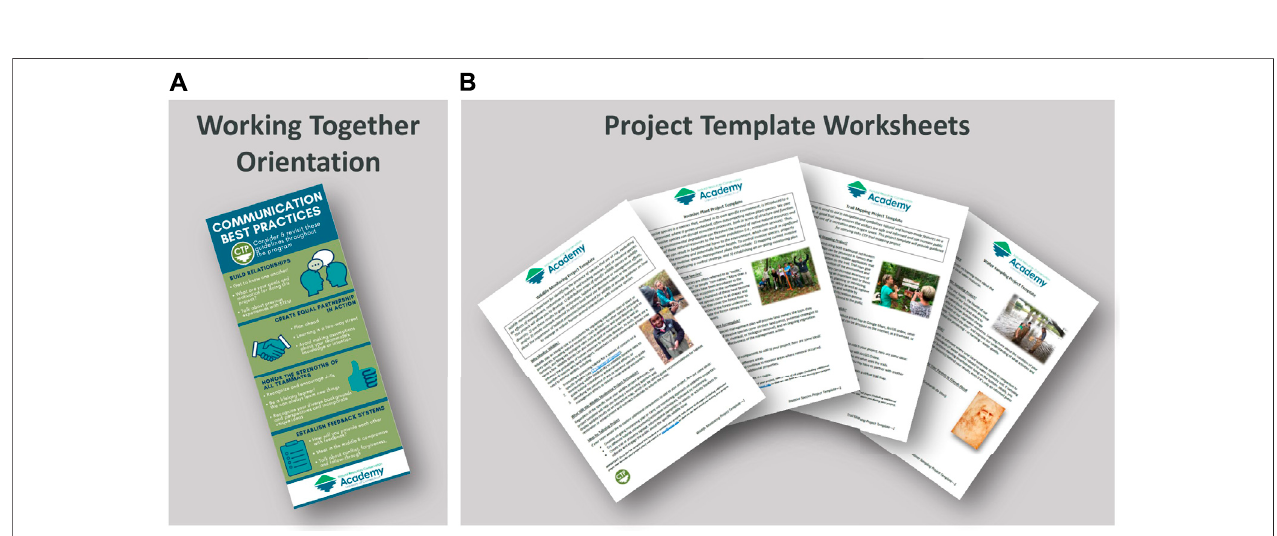
FIGURE2| Images oftwotypes ofparticipant project support documents (A) communicationbest practices tofacilitate collaborative intergenerational teamwork, presented during a participant orientation and revisited throughout the program, and (B) project planning templates to provide a heuristic approach for scaffolding intergenerational team project development. See all original documents in the Supplementary